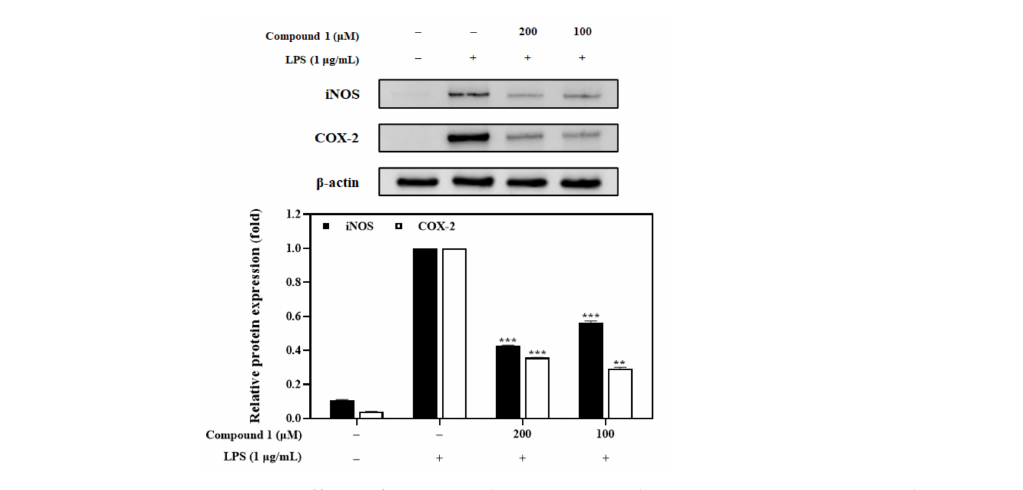
Figure 8. Effects of compound 1 on iNOS and COX-2 expression. Macrophages were incubated in the presence of compound 1 (100 and 200 µ M) for 2 h and induced with LPS (1 µ g/mL) for 20 h. The levels of iNOS, COX-2, and β -actin in the LPS-induced cells were analyzed by western blot analysis. Relative density was calculated as the ratio of the expression level of each protein with β -actin. Data are represented as mean ± SD. ** p < 0.01 and *** p < 0.001 vs. LPS-treated group.